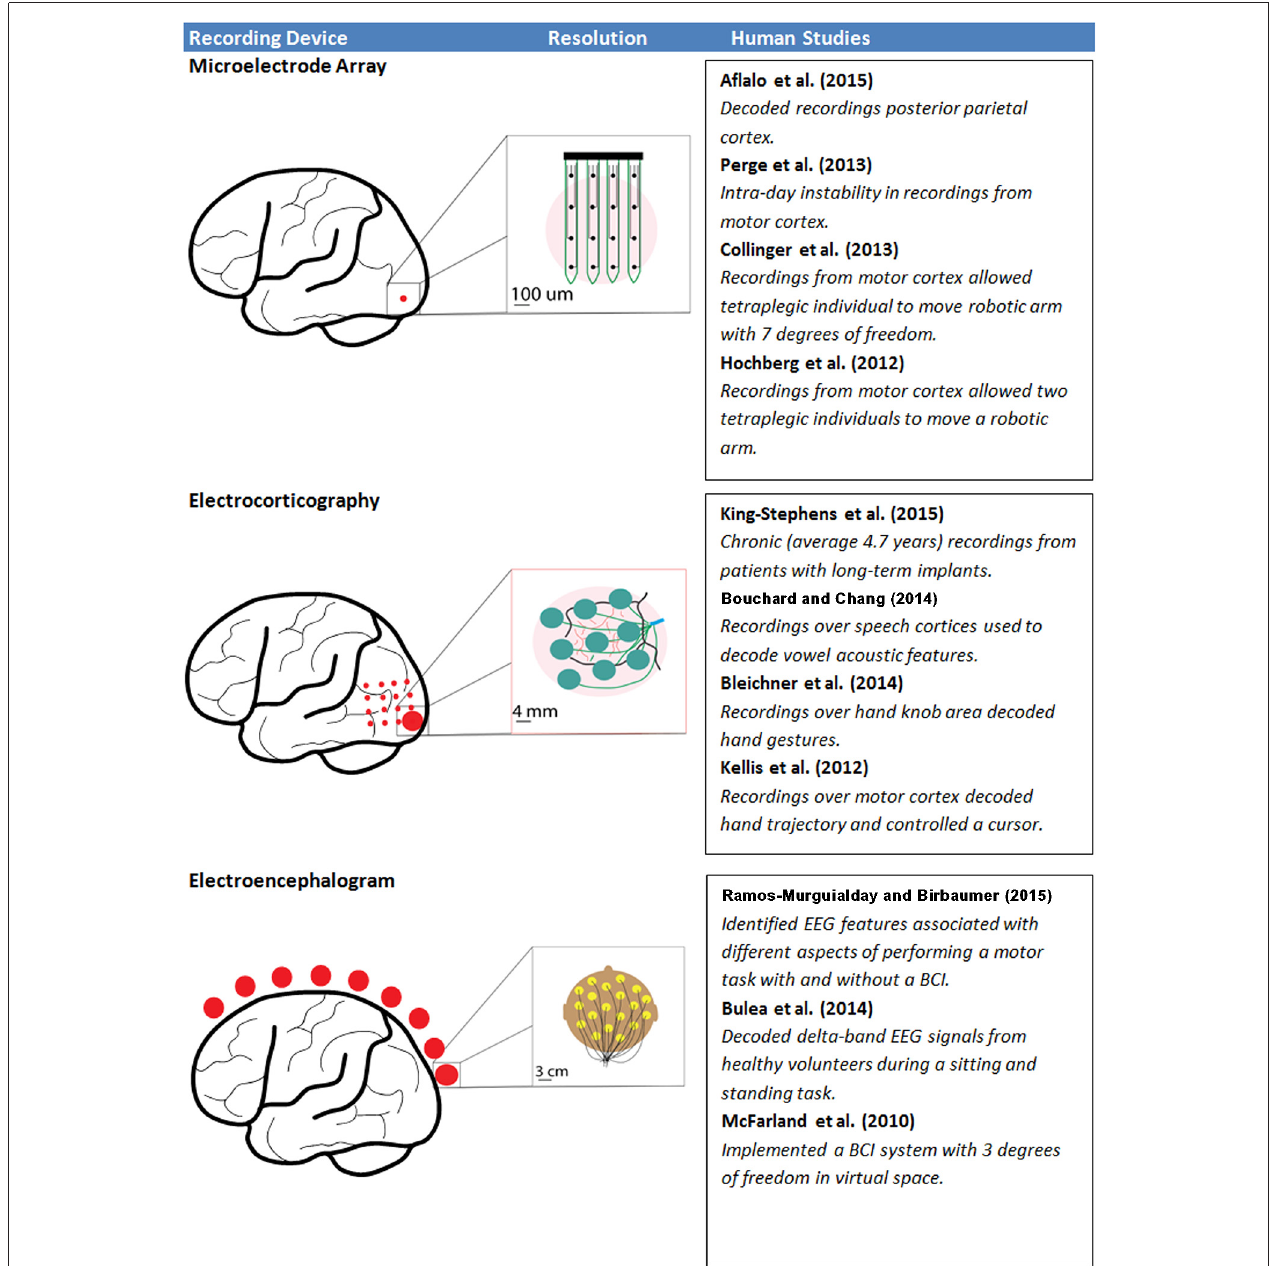
FIGURE 1 | The resolution of each type of recording interface, as well as a selection of recent human studies associated with each interface. Red dots represent the relative extent of recording interface placement, while inserts demonstrate the scale and possible arrangement of electrodes at that site.